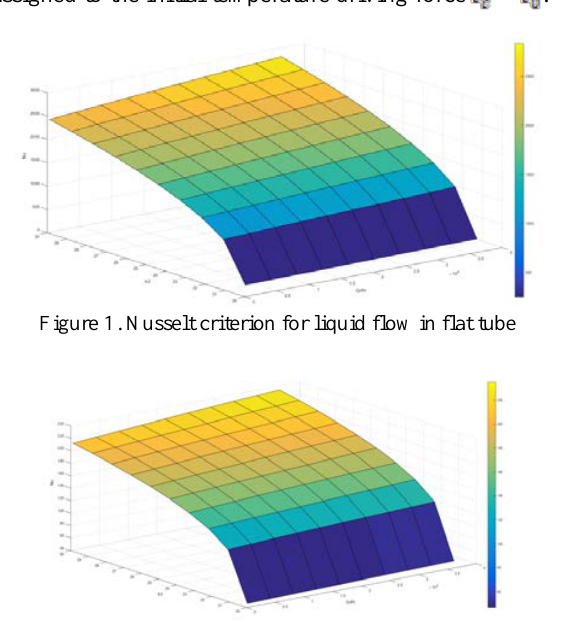
Figure 2. Nusselt criterion for liquid flow in circular tube